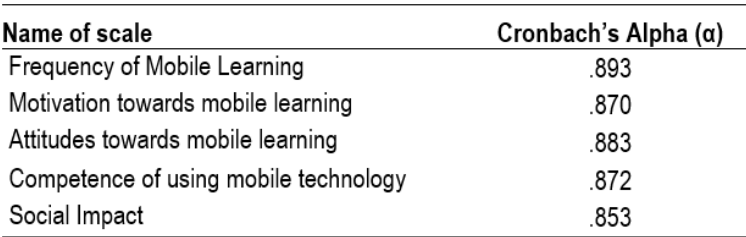
Findings of Cronbach’s alpha reliability